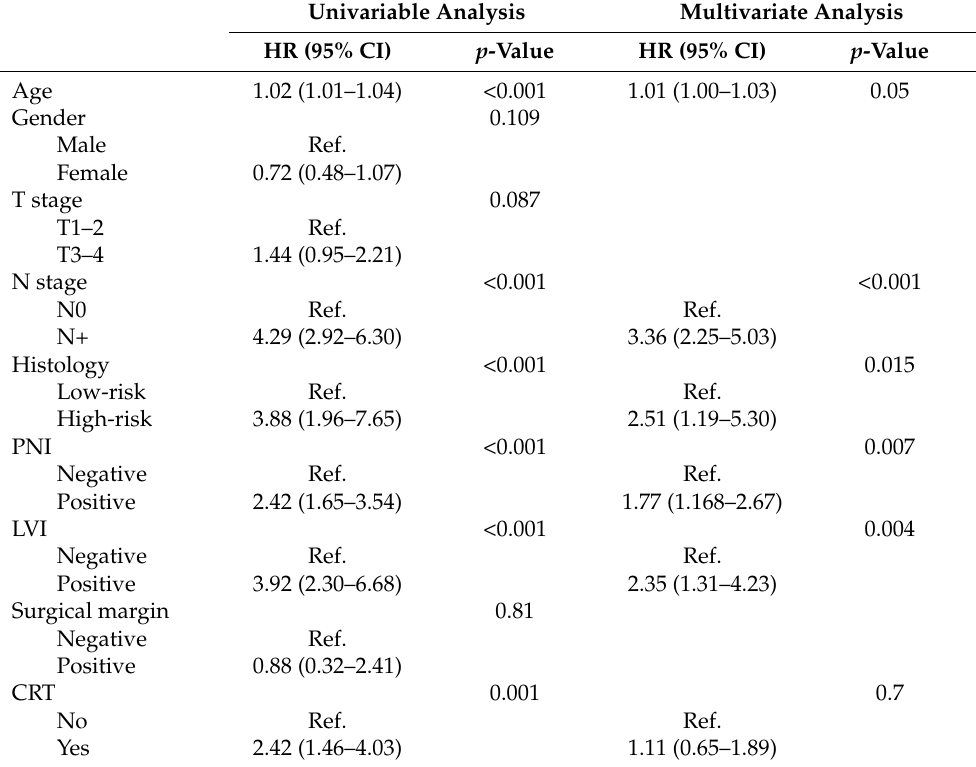
Table 2. Univariable and multivariate analysis for DM with a competing-risk method ( n = 586). Univariable